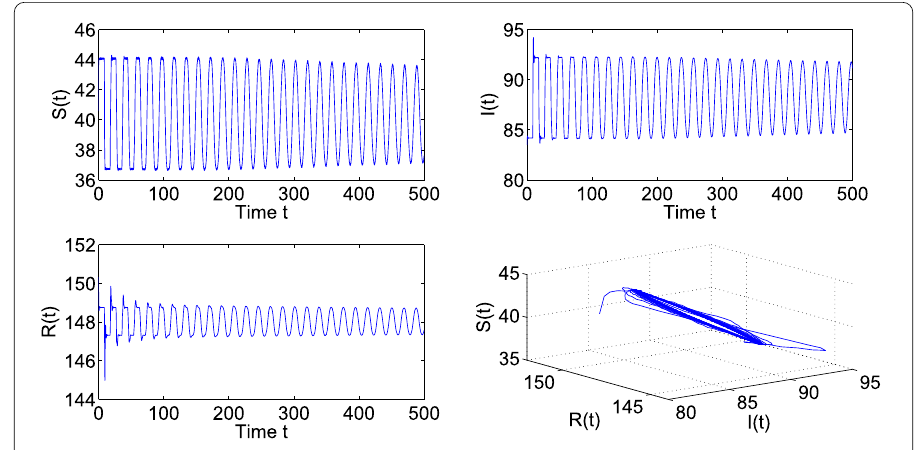
Figure 9 System (45) under goes a Hopf bifurcation when τ 1 = 8.896 > τ ∗ 10 = 4.0945 and τ 2 = 0.55 ∈ (0, τ 20